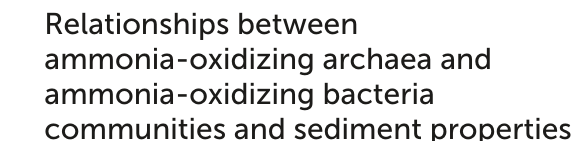
*Differentsuperscriptlettersindicatesignificantdifferencesbetweensamplesatdifferenttimes( p < 0.05, n =3).